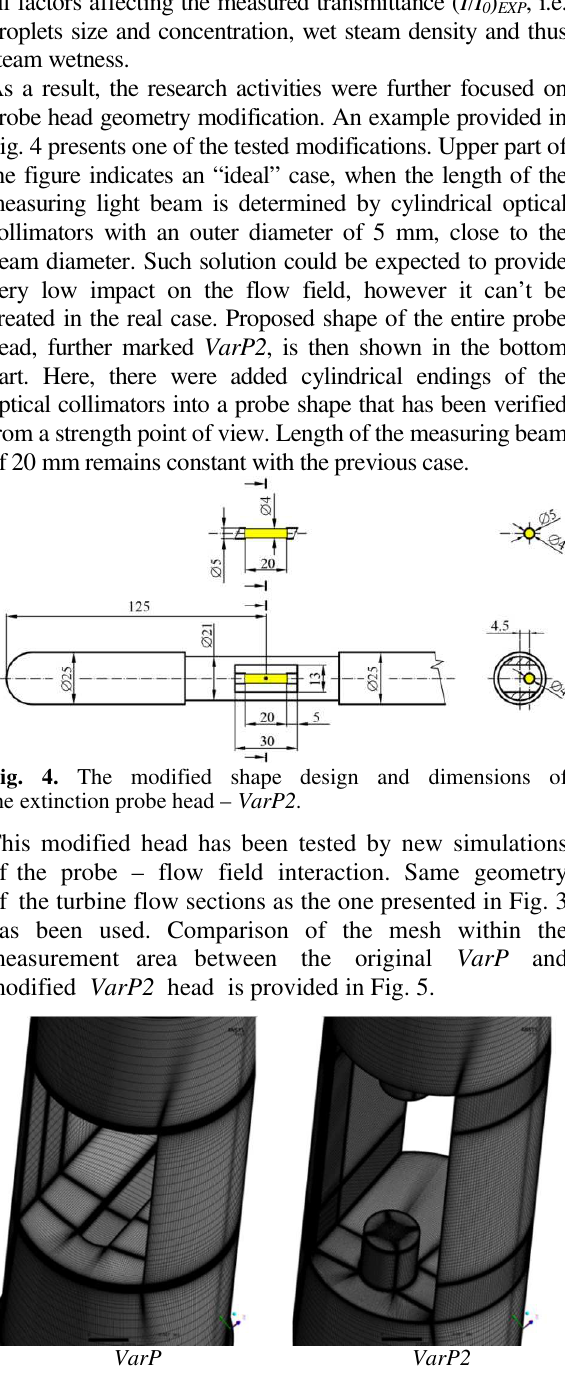
Fig. 5 . Surface mesh detail of the extinction